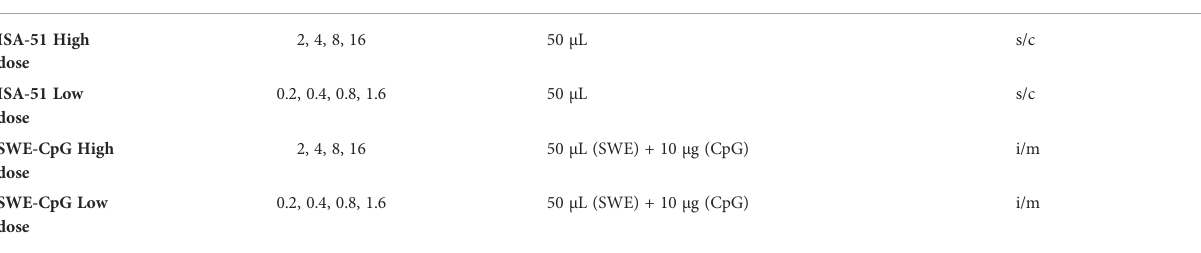
TABLE 1 Vaccine formulations for allergen-speci fi c